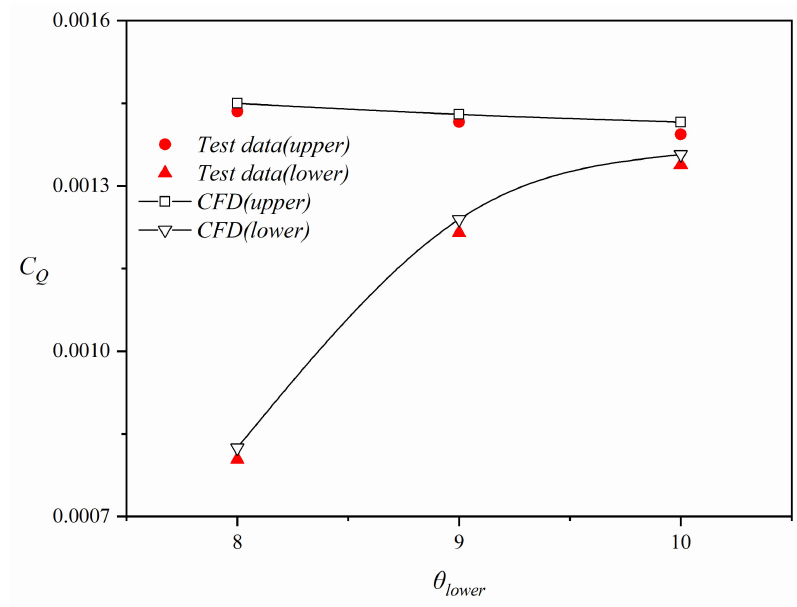
Figure 8. C Q of the upper and lower rotors in forward